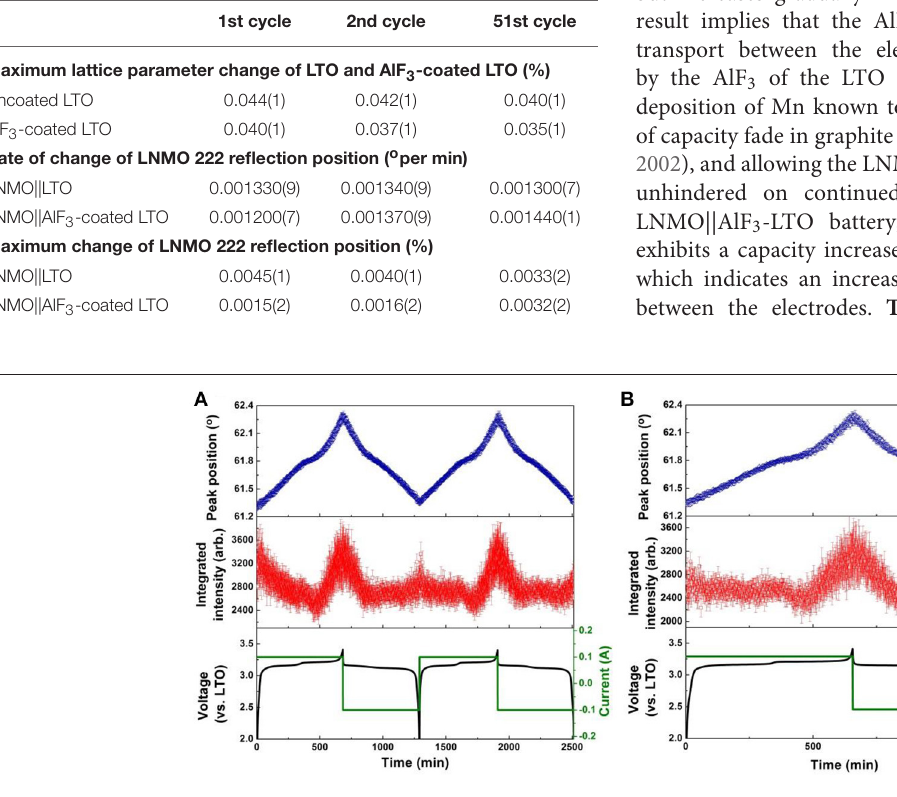
FIGURE 7 | Results of single peak fitting of the LNMO 222 reflection of NPD data for the LNMO||LTO battery, including peak position and intensity, for (A) the first two cycles, and (B) the 51st cycle. Battery voltage and current are also shown.